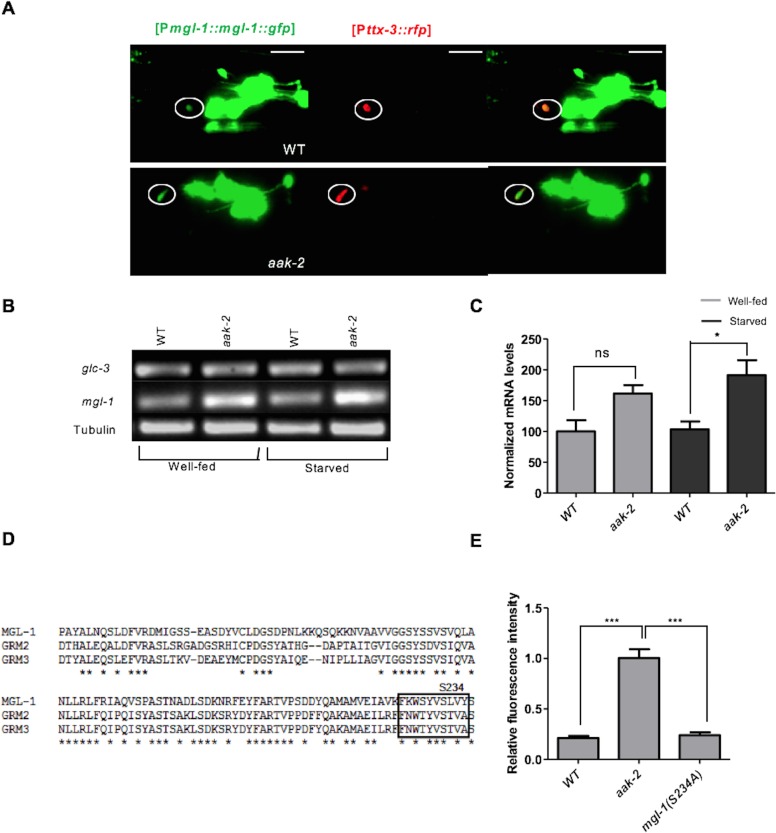
AMPK regulates MGL-1 by modulating its steady state mRNA levels while also affecting MGL-1 function through direct phosphorylation.(A) [MGL-1::GFP] levels are unchanged in well fed WT and aak-2 mutants in the AIY interneurons (shown in the circle) indicated by [TTX-3::RFP]. Scale bars represent 20 μm. (B,C) Relative messenger RNA levels were analyzed with semi-quantitative RT-PCR in well-fed and starved animals. mgl-1 mRNA levels (normalized to WT) are significantly higher in starved aak-2 mutants compared to starved WT animals. Error bars represent ± SEM (two-way ANOVA *p<0.05). (D) A schematic showing the conserved AMPK phosphorylation site in C. elegans MGL-1 and human GRM2 and GRM3 group II metabotropic glutamate receptors. (E) Normalized [MGL-1::GFP] levels are unchanged upon mutating serine 234 in mgl-1 (n>10), Error bars represent ± SEM (one-way ANOVA ***p<0.0001).